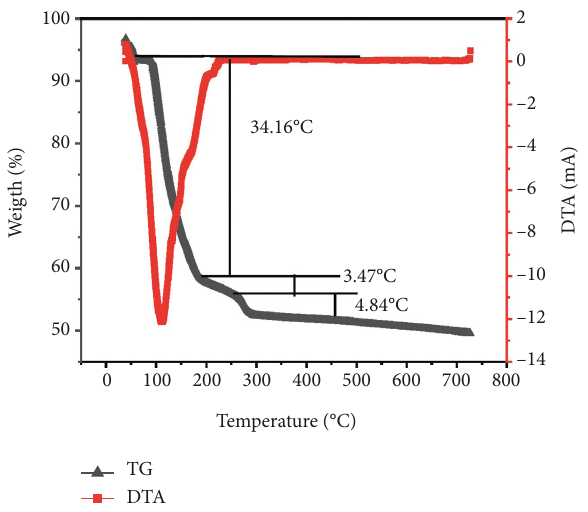
Figure 11: TG/DTA spectra of the methyl orange dye-doped K 2 SO 4 single crystal.